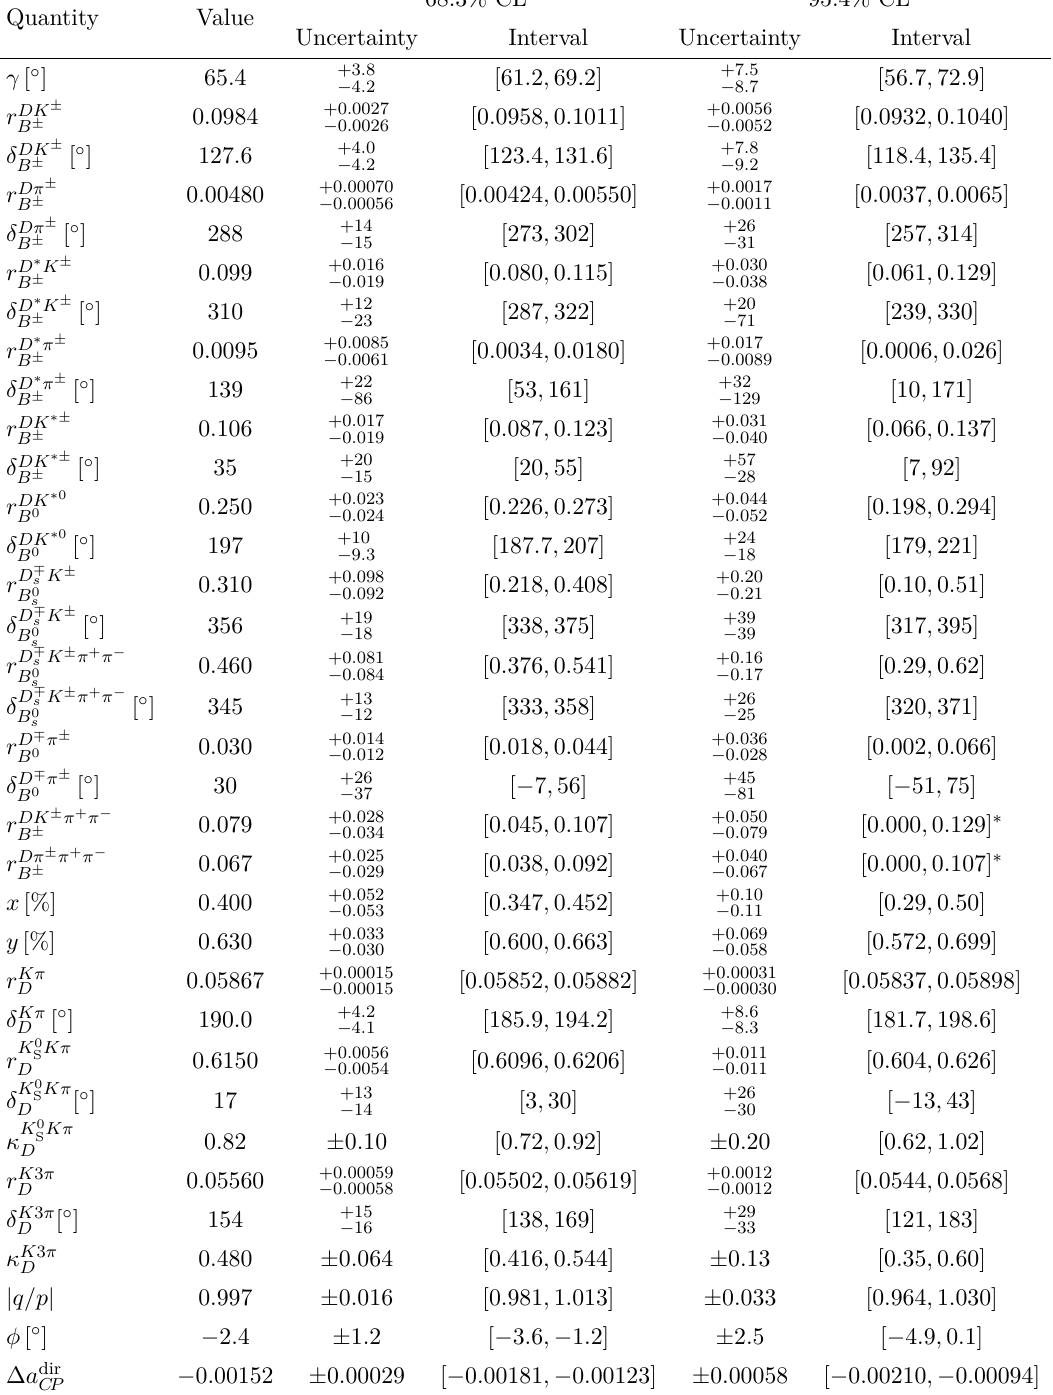
Table 3 . Confidence intervals and central values for each of the parameters of interest. Entries marked with an asterisk show where the scan has hit a physical boundary at the lower